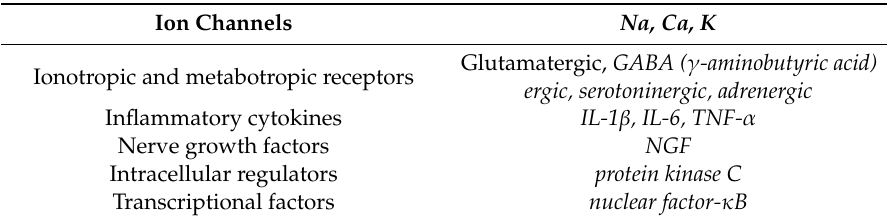
Table 2. Cellular and intracellular elements